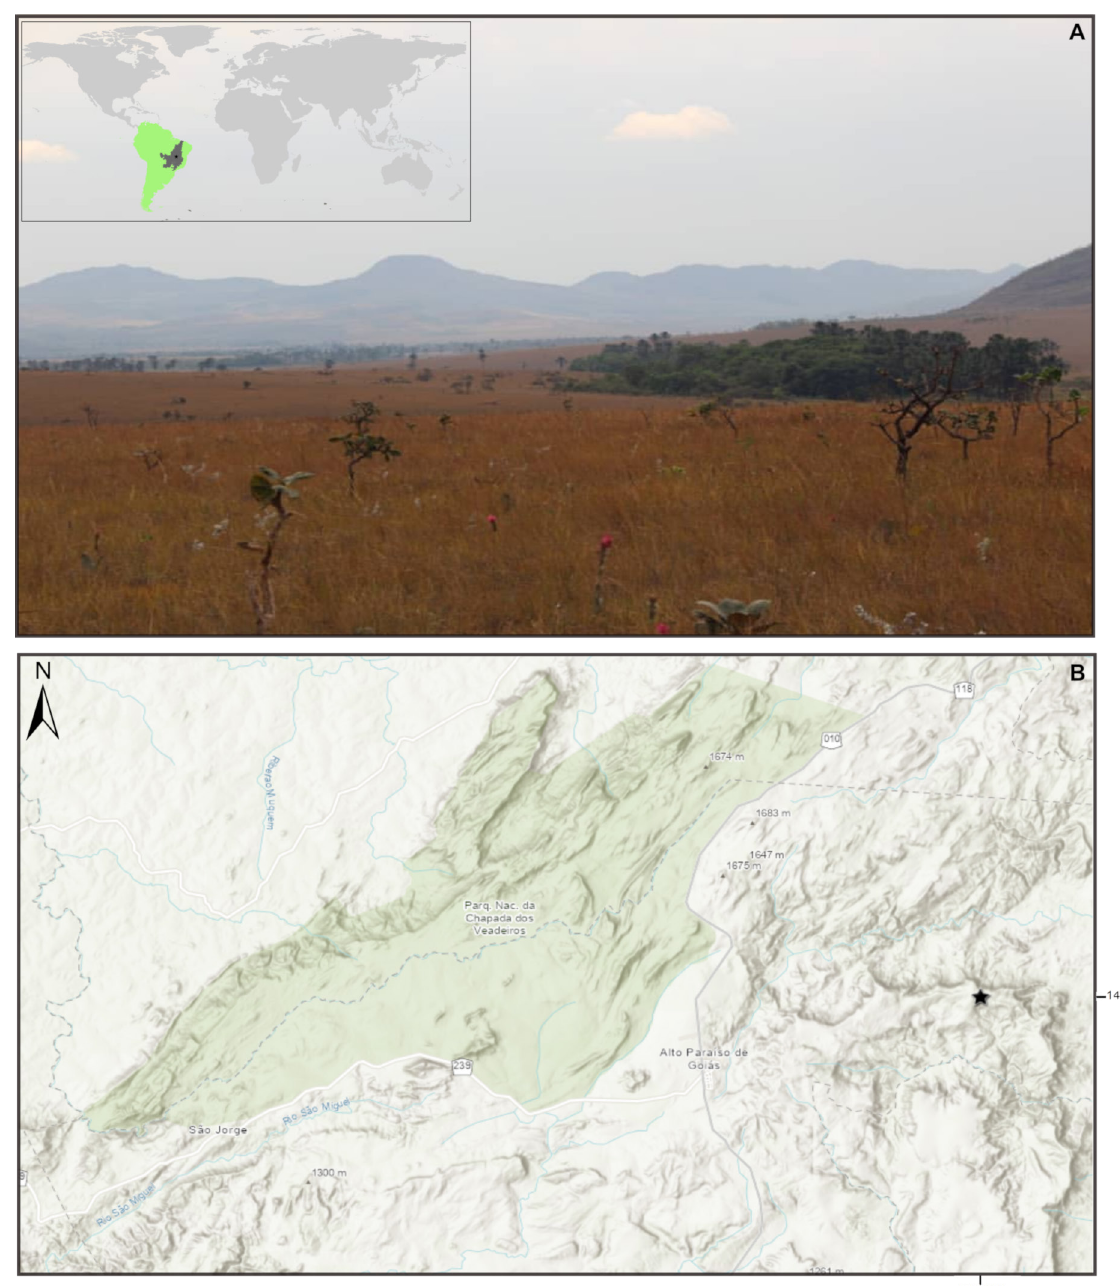
Fig. 2. Habitat and distribution of Hemipogon trilobatus Bitencourt & Rapini sp. nov. A . Open savannah in Chapada dos Veadeiros, state of Goiás, Brazil. Photo by CB. B . Map showing the geographic distribution of H. trilobatus sp. nov. in the Cerrado domain (shaded area at reference map in A) and its occurrence (black star) nearby the Chapada dos Veadeiros National Park. Images and distribution maps were built and exported using ArcGIS online (https://www.arcgis.com). © Esri and its licensors, all rights